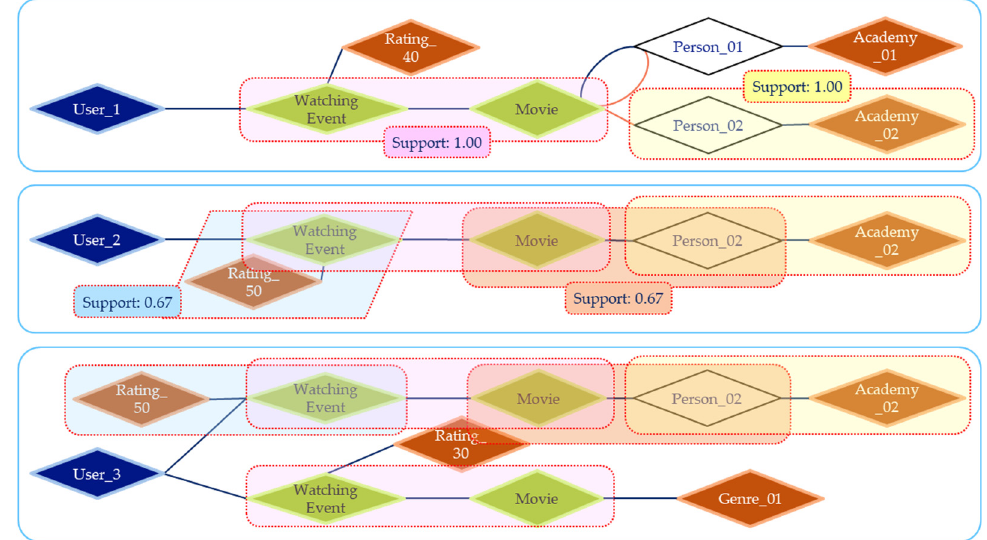
Figure 11. Candidates in unit subgraphs after 1st candidate generation. Meanwhile, the instances corresponding to the “{Watching Event Movie}” classes are changed to class, as shown in green, and the frequency and support are calculated at